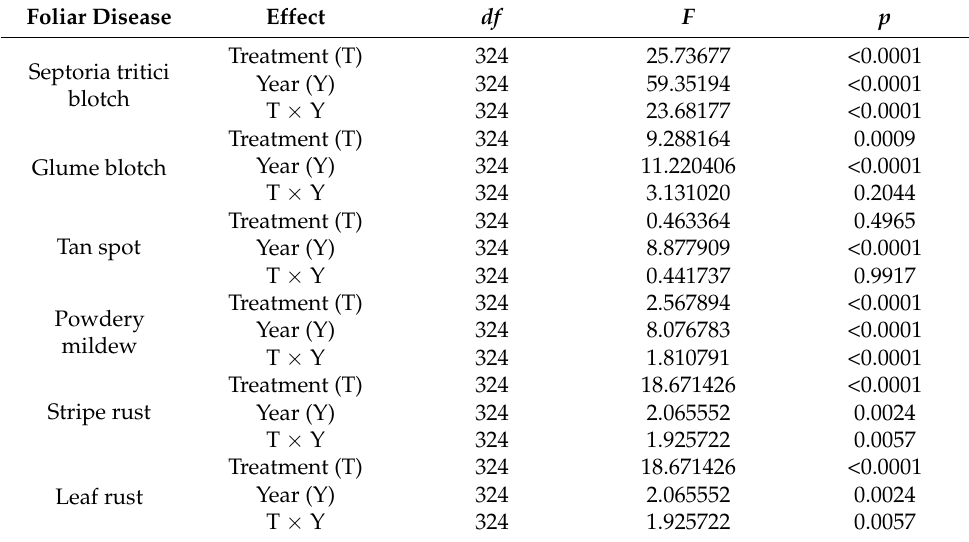
Table 3. Analyses of variances (ANOVAs) for the effect of treatment (untreated control, IPM), year (1995–2021), and their interaction on disease severities (WAUDPC; F-0 70%; F-1 20%; F-2 10%; F-3 to F-6 0%) of the wheat foliar diseases Septoria tritici blotch, glume blotch, tan spot, powdery mildew, stripe rust and leaf rust. Foliar Disease Effect df F Septoria tritici blotch